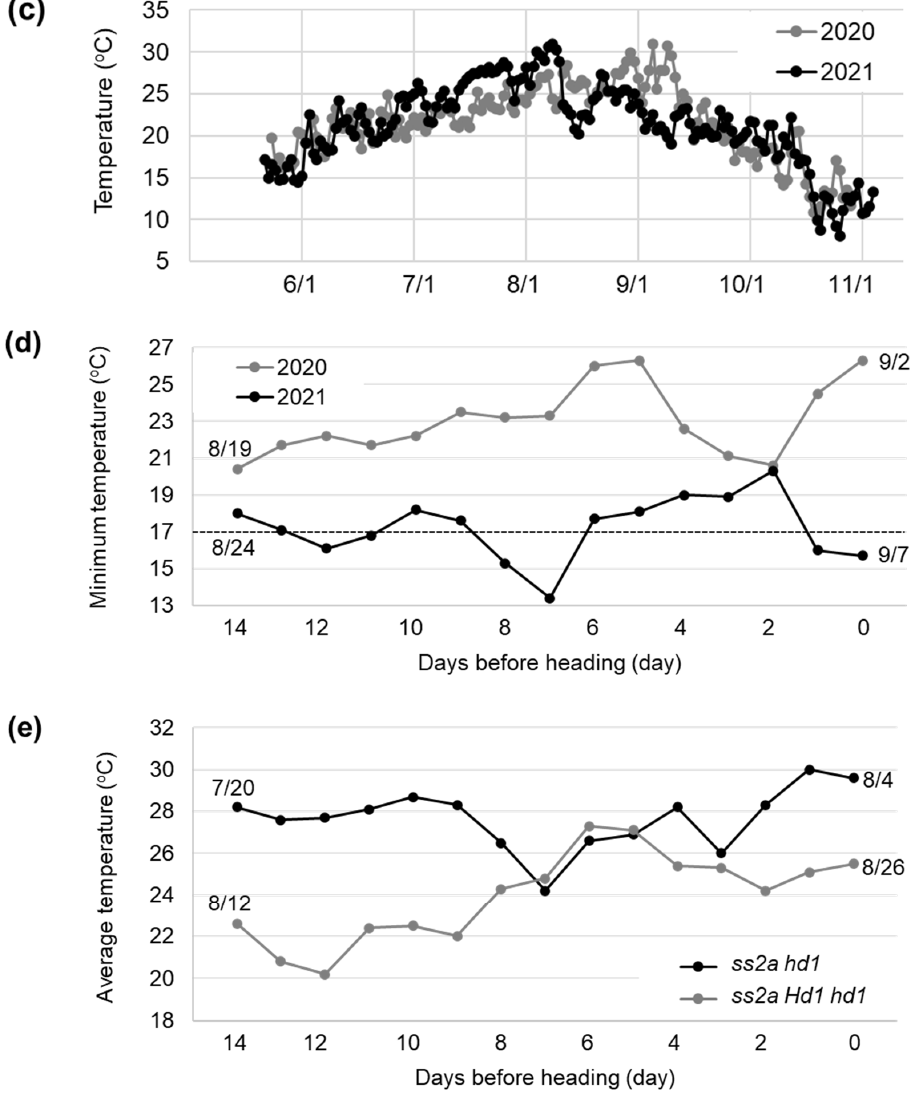
Figure 5. Comparison of the heading dates of ss2a Hd1 , ss2a Hd1 hd1 , and ss2a hd1 . ( a ) Photo of NILs showing the differences in their heading dates. Note that ss2a hd1 is mature, ss2a Hd1 hd1 is at the mid-developmental stage, and ss2a Hd1 is still flowering. ( b ) Differences among rice NILs in the number of days to heading and to maturity. Numbers (month/day) below the ribbon represent the actual dates of sowing, transplanting, heading, flowering, and maturity. ( c ) Average day temperature during the period from the end of May (transplanting) to the beginning of November (harvesting) in 2020 (gray) and 2021 (black). ( d ) Minimum temperature for 2 weeks before the heading date of ss2a Hd1 in 2020 (gray) and 2021 (black). Dashed line indicates the threshold temperature (17 °C) that reduces the fertility rate. ( e ) Average temperature for 2 weeks before the heading date of ss2a hd1 (black) and ss2a Hd1 hd1 (gray) in 2021.